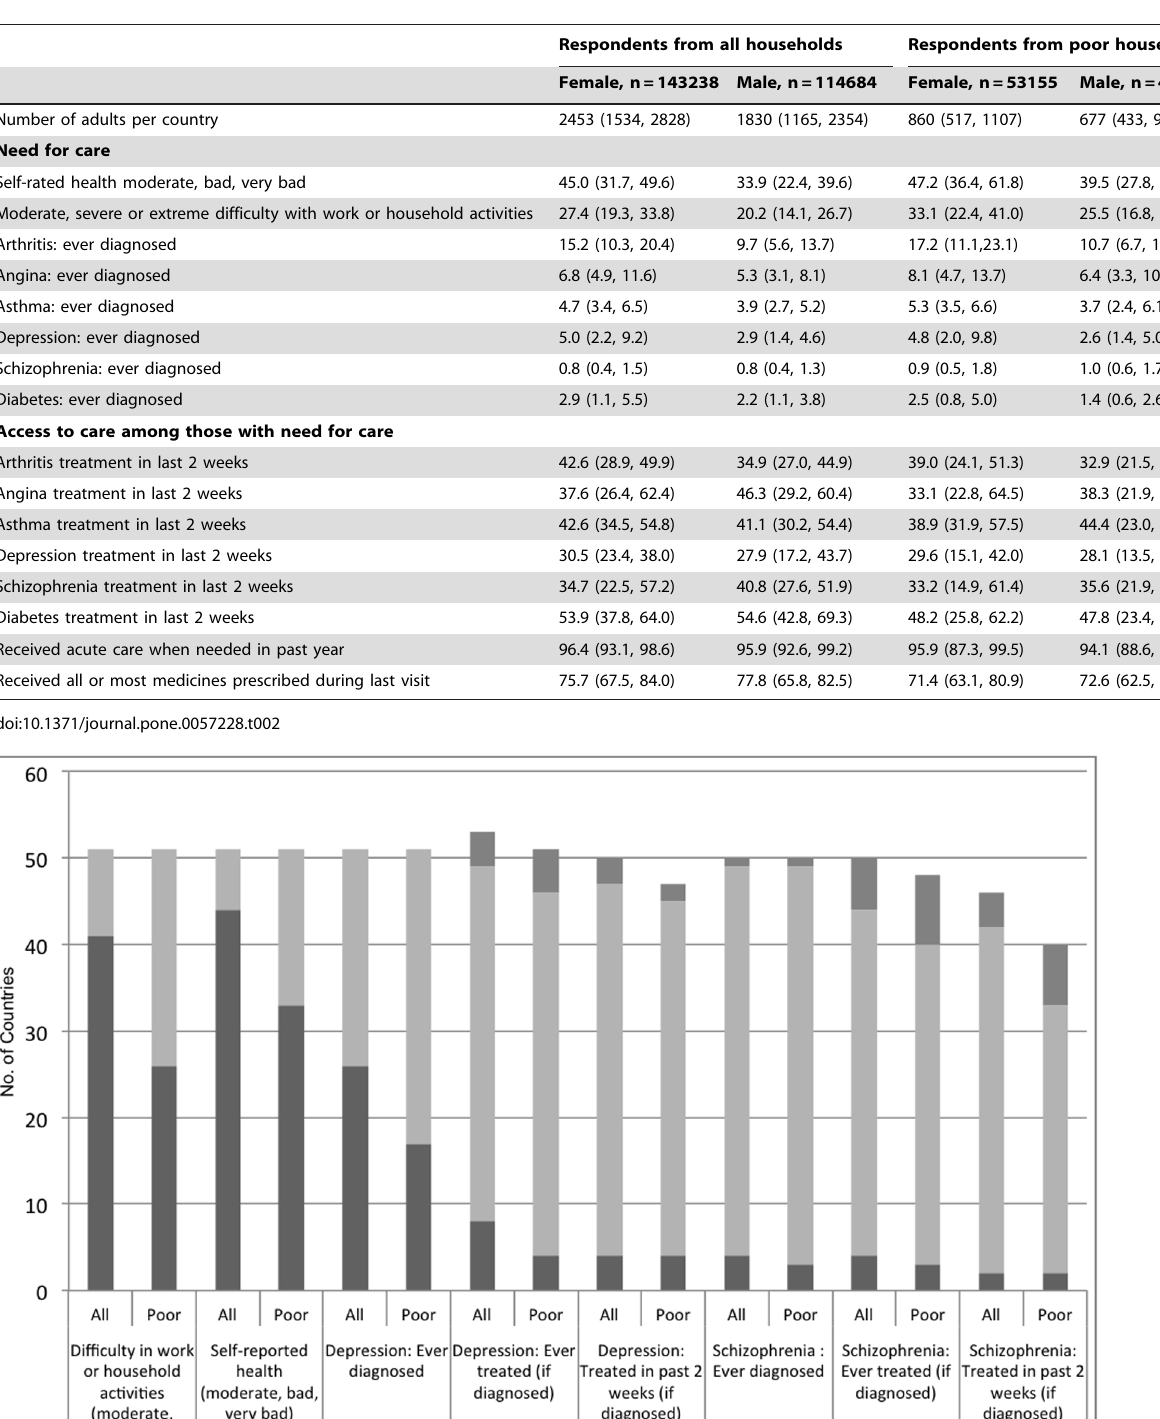
Table 2. Median (interquartile range) of percentage of adult respondents with need for and access to care in 53 countries.